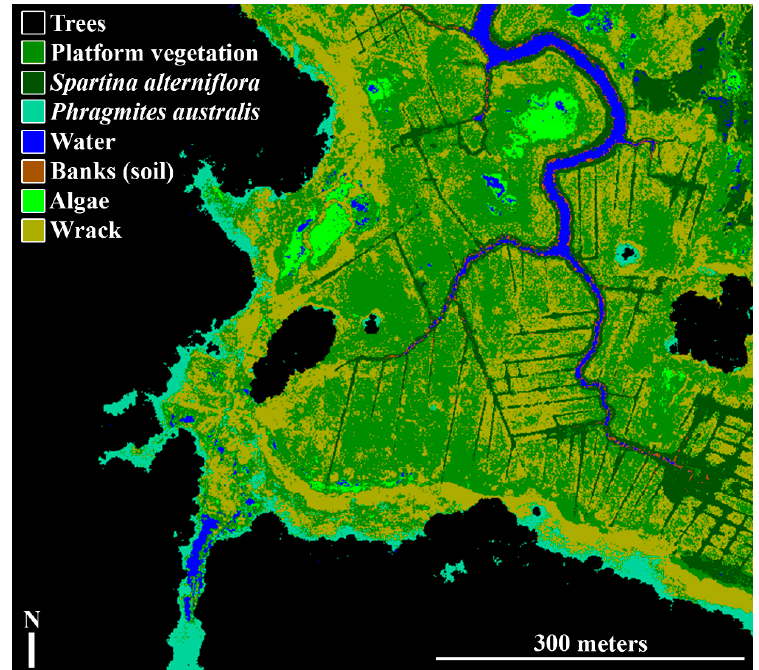
Figure 8 . Classification map (1 m resolution) based on airborne lidar acquisitions in 2015.